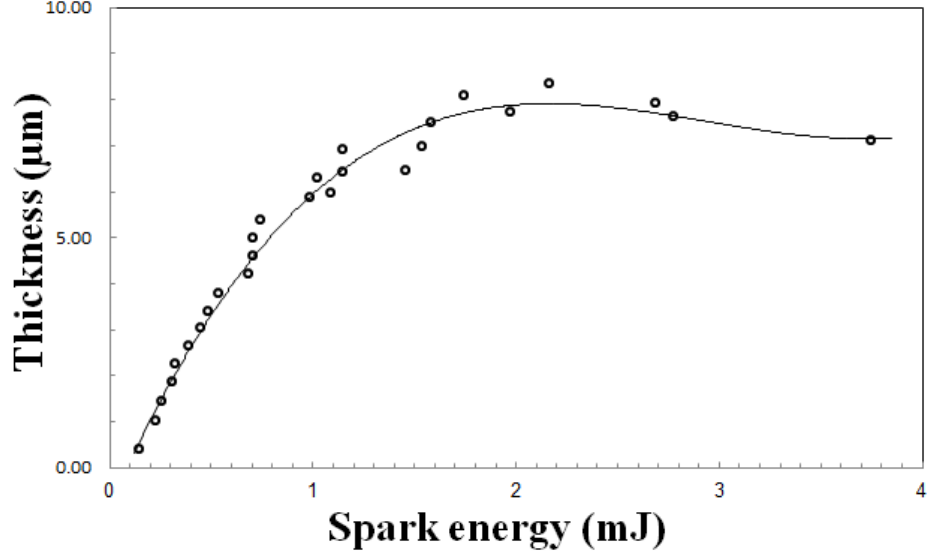
Figure 8. Variation of thickness of coated samples with spark energy.